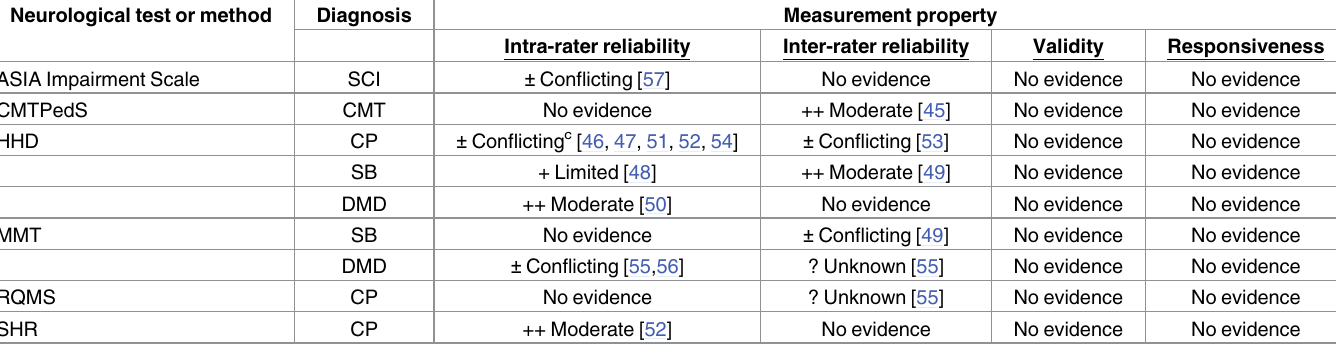
Table 7. Levels of evidence a of lower limb strength measurements based on Brink and Louw b methodological quality. Neurological test or